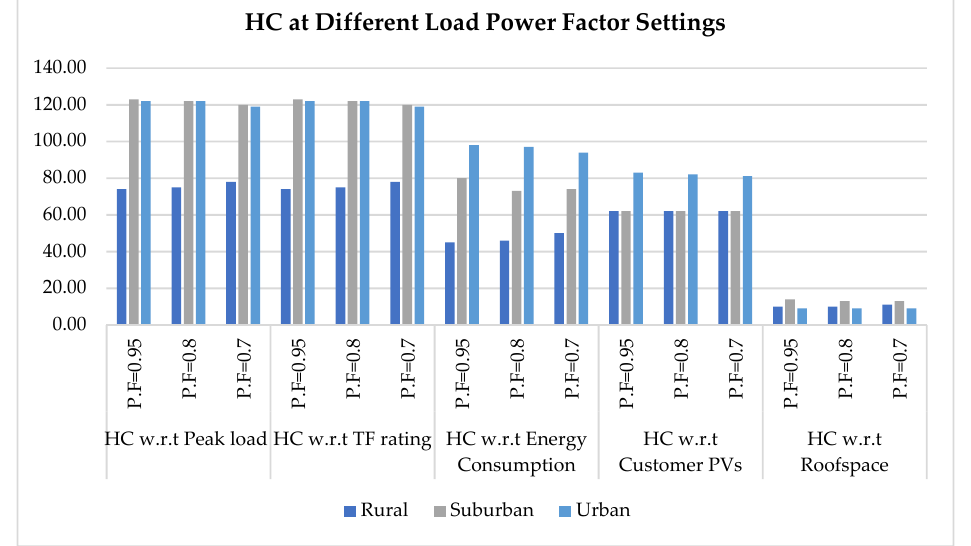
Figure 6. HC comparison for balanced PVs by taking maximum load as 100% of transformer rating for three load power factor settings of 0.95, 0.8, and 0.7 for the three regions.